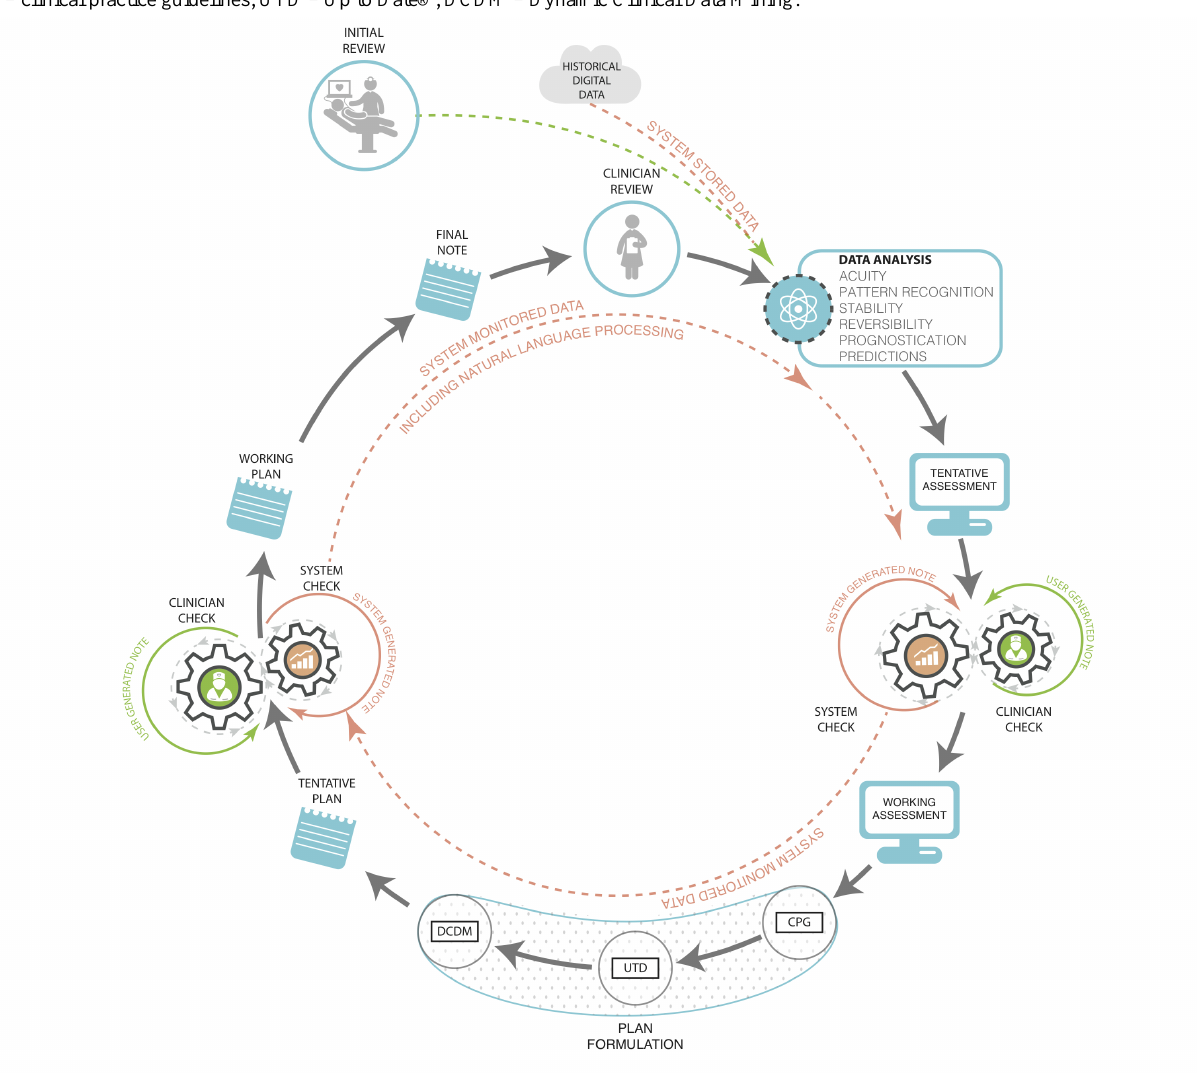
Figure 1. Clinician documentation with fully integrated data systems support. Prior notes and data are input for the following note and decisions. Machine analyzes input and displays suggested diagnoses and problem list, and test and treatment recommendations based on various levels of